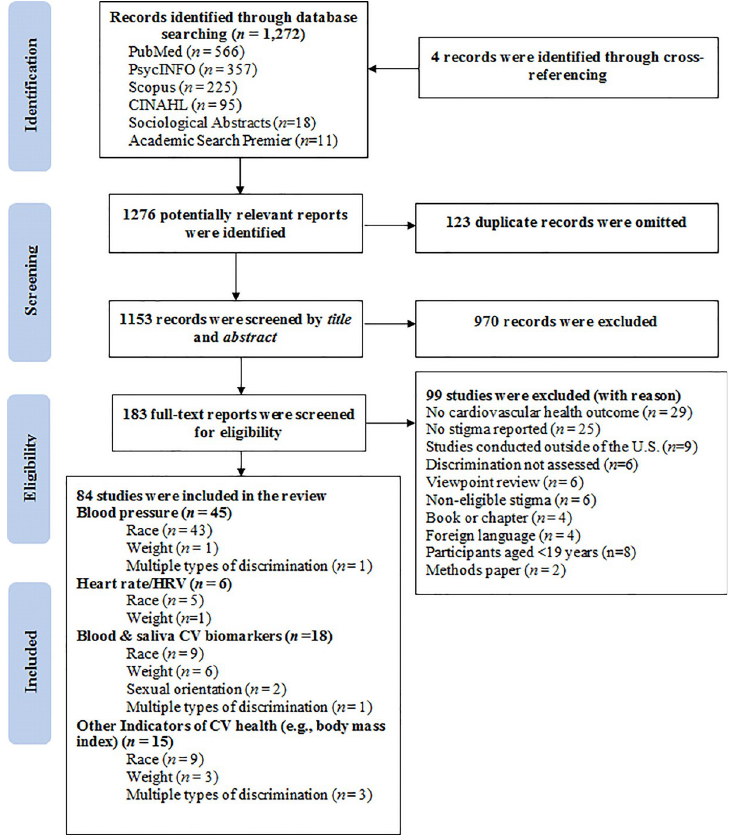
Fig 1. Flow chart detailing the systematic search of potential reports and selection process of included studies ( n ). CV = cardiovascular; HRV = heart rate variability.